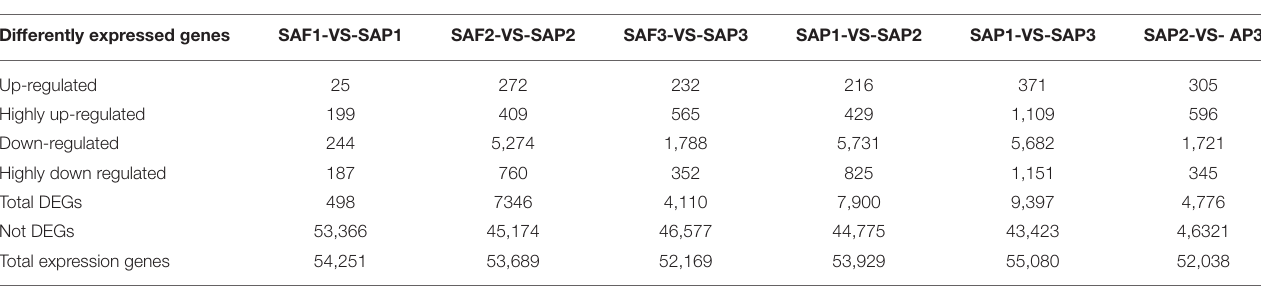
TABLE 3 | Gene expression levels across different sample